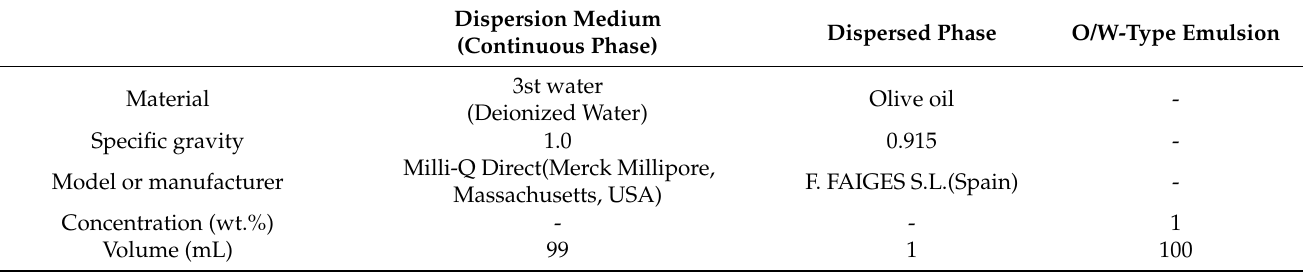
Table 1. Water and oil used for emulsion